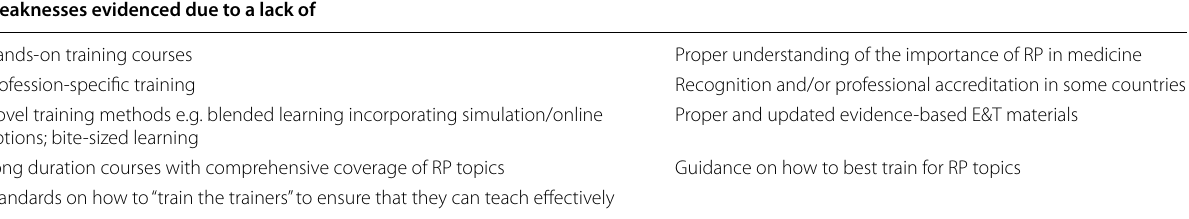
Table 1 Summary of the weaknesses identified by SWOT analysis Weaknesses evidenced due to a lack of Hands-on training courses Profession-specific